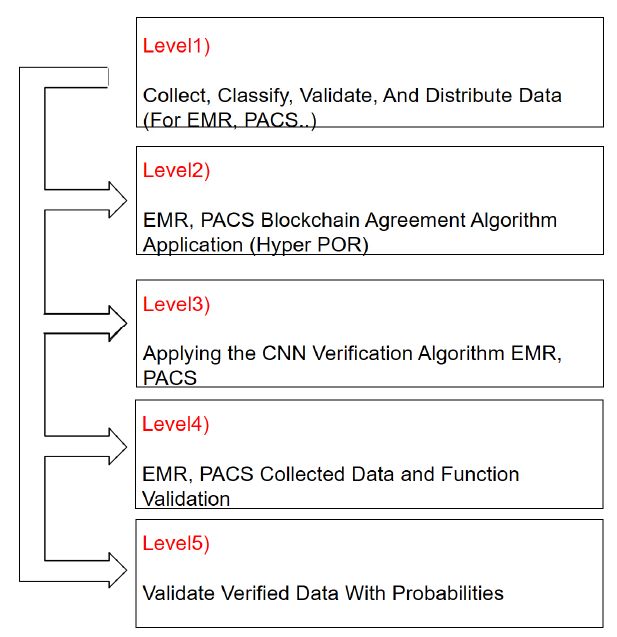
Figure 11. CNN intelligent agent cloud architecture flowchart.